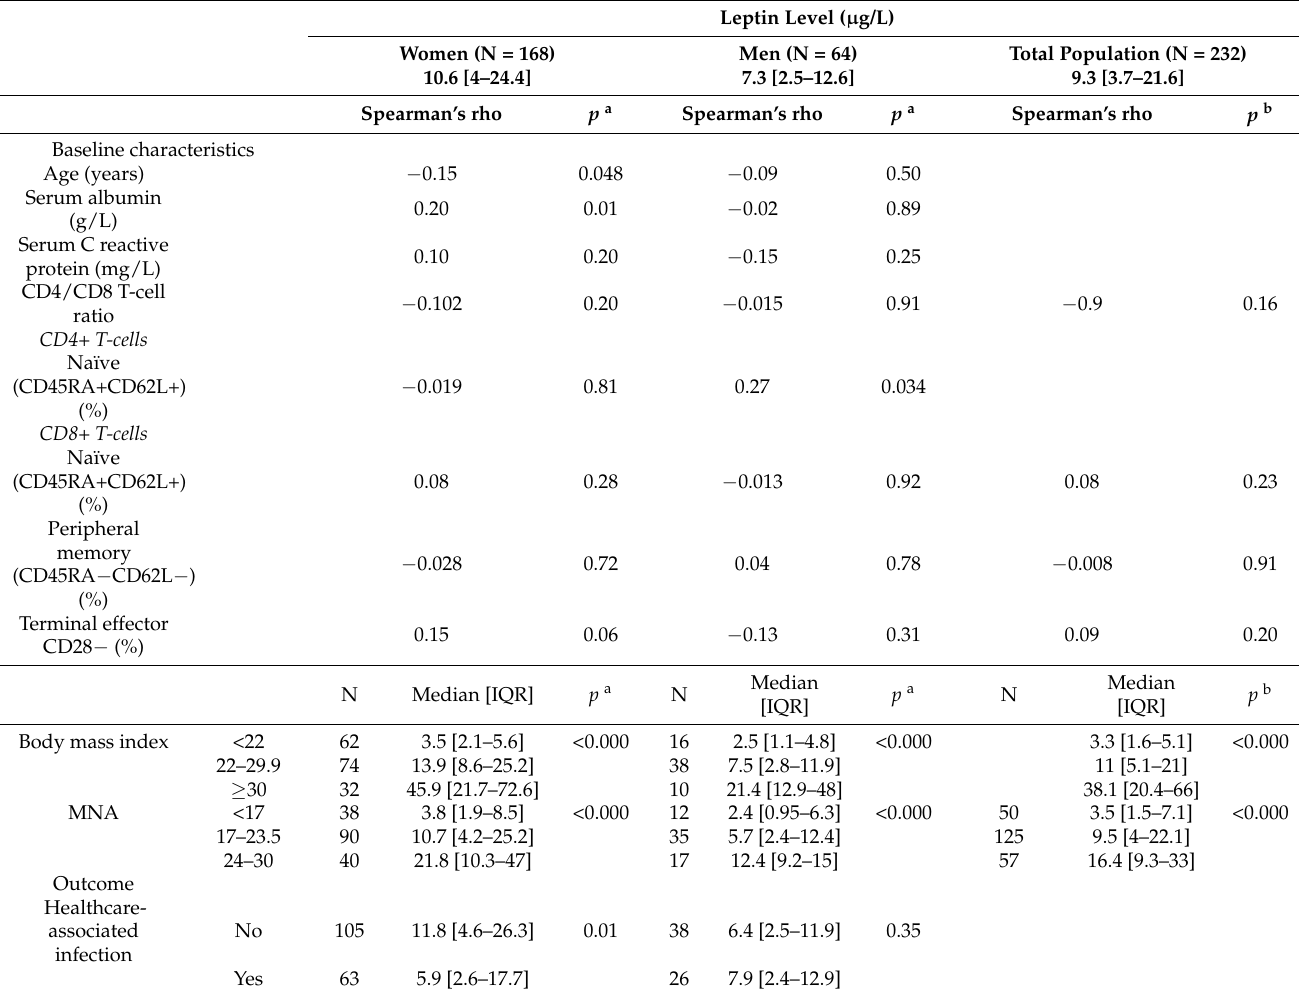
Table 2. Baseline characteristics and outcomes associated with the leptin level in the study population (n =